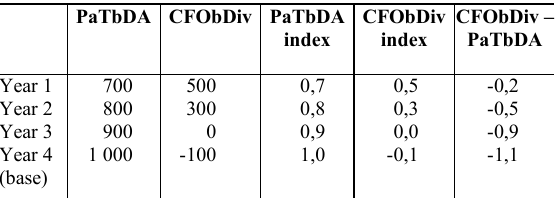
Table 1: Calculation of the cumulative